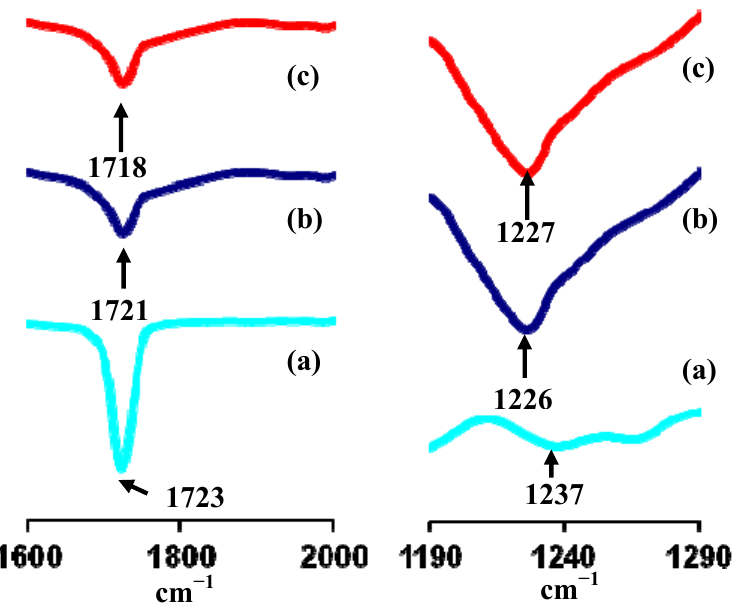
SO CF added with 35 wt % 4 3 3